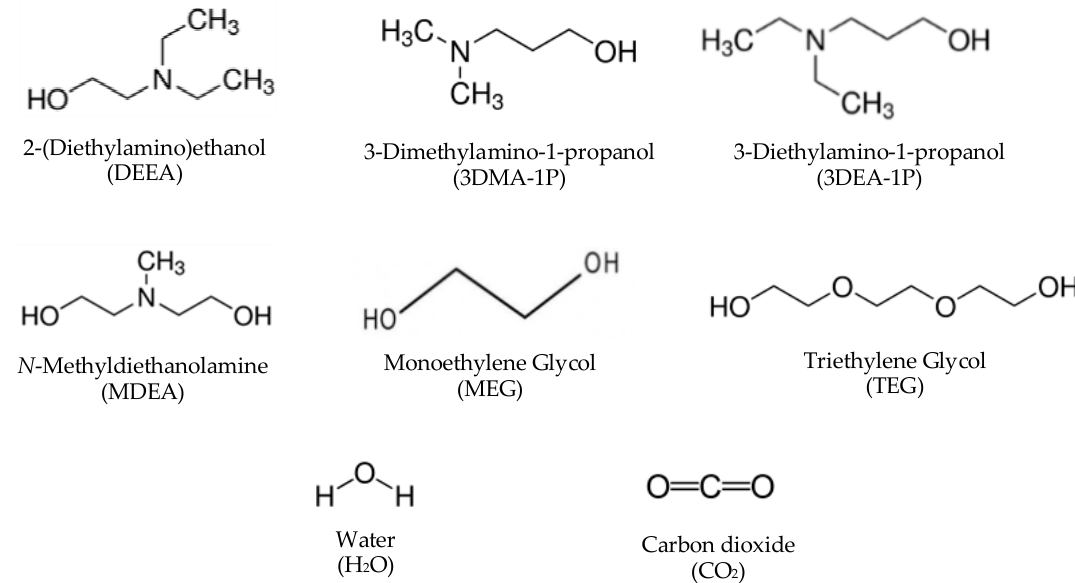
Figure 1. Chemical structures of all chemicals used in this study.